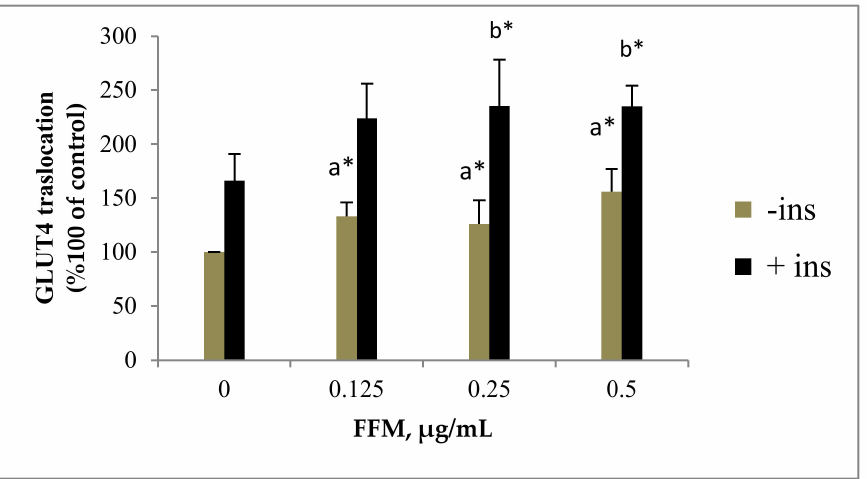
Figure 3. Effect of FFM on GLUT4 translocation. GLUT4 L6-GLUT4myc cells (100,000 cell/well) were exposed to FFM for 20 h. Serum-depleted cells were treated without ( − ) or with (+) 1 nM insulin for 20 min at 37 ◦ C and surface myc-tagged GLUT4 density was quantified using the antibody-coupled colorimetric assay. Values given represent means ± SEM (% of untreated control cells) of three independent experiments carried out in triplicates. * p < 0.05; a: compared with − insulin control group, b: compared with + insulin control group.